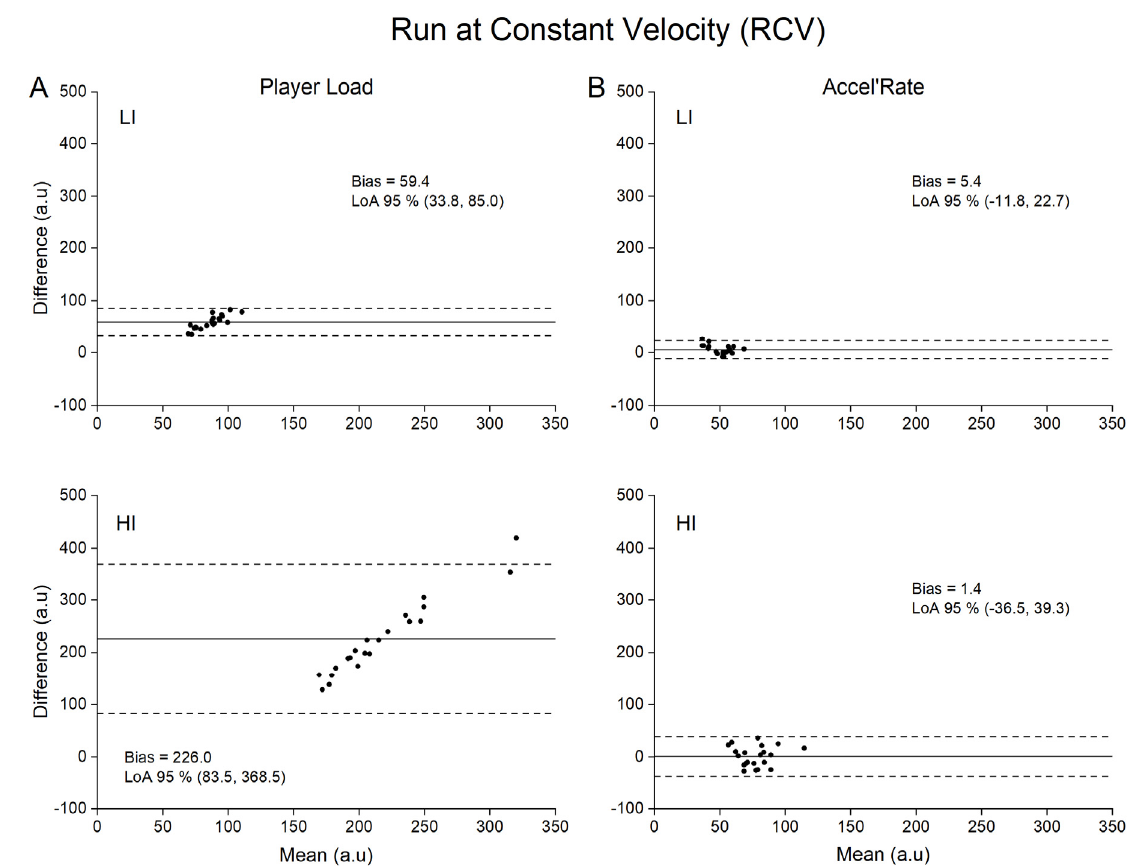
Figure 4. Bland-Altman plots of difference between criterion and practical measurements for run at constant velocity (RCV). For the sake of clarity, only data obtained for the upper back position are depicted. ( A ): Player Load measured by accelerometer (practical) versus by force plates (criterion) at low (LI) and high (HI) intensity; ( B ): Accel’Rate measured by accelerometer (practical) versus by force plates (criterion) at low (LI) and high (HI) intensity. Solid lines depict mean bias and dashed lines depict 95% limits of agreement (LoA).